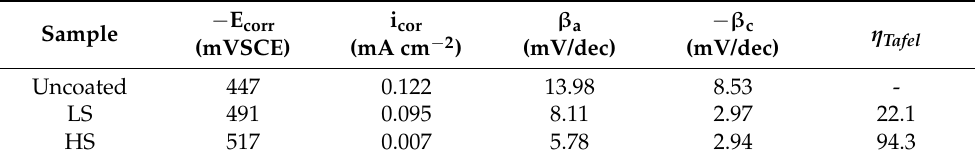
Figure 10. The polarization curves of the uncoated, LS and HS samples in the 0.5 M HCl solution at 30 ◦ C. Table 4. Polarization data of the uncoated, LS and HS samples in the 0.5 M HCl solution at 30 ◦